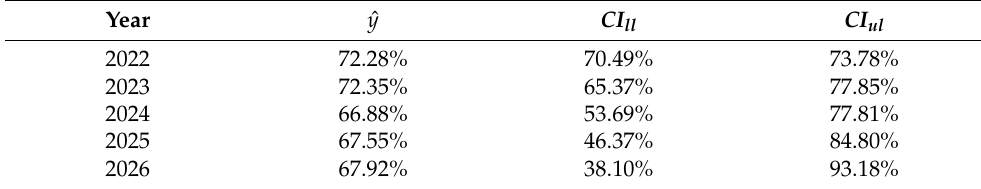
Table 7. Projection of population coverage of privately funded CC screening in Poland.